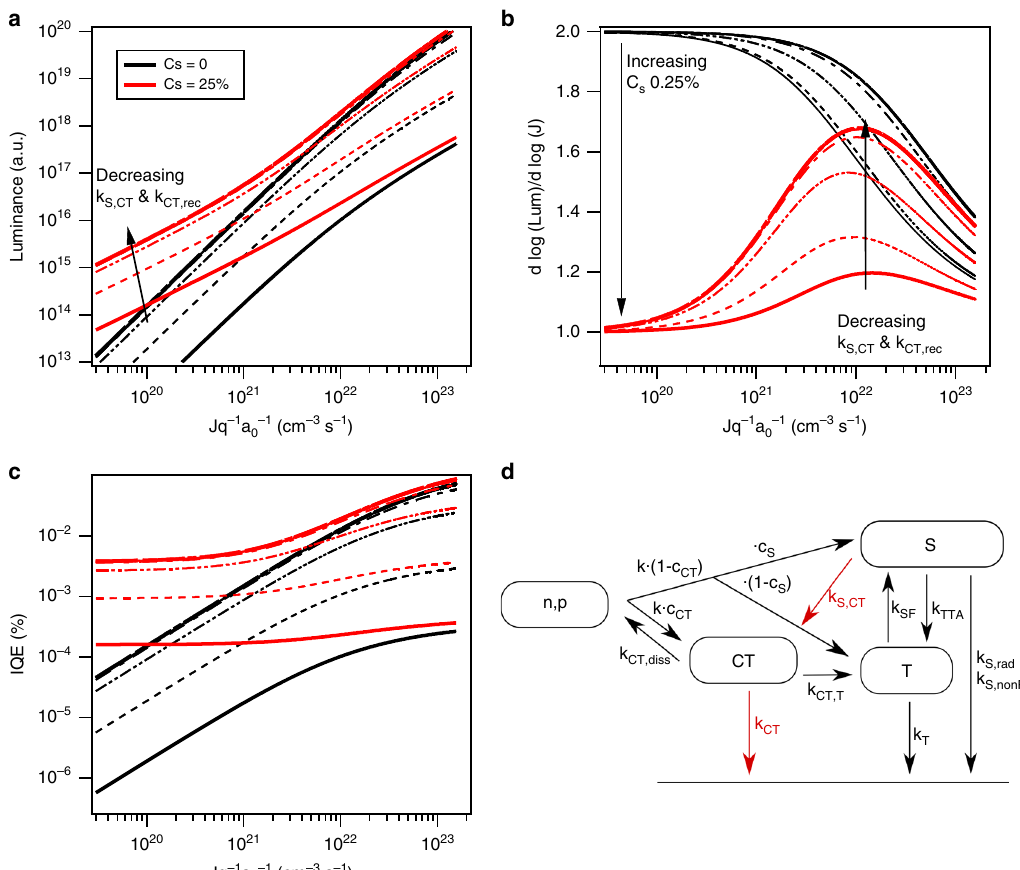
Fig. 9 Kinetic model results. a Simulated L ( J )-characteristics, ( b ) ∂ log( L )/ ∂ log( J ), and ( c ) current ef fi ciency of rubrene-based OLEDs. The data were calculated using Eq. (2) – (5) and literature values for k TTA = 10 − 14 cm 3 /s, τ T = 100 μ s, τ SF = 5 ps, τ nonRad = 50 ps, and τ rad = 15 ns, c CT = 50%, and k T ,CT = 0. Assumed values: τ CT = 50 ns; τ CT, T = 10 ps, τ S ,CT = 10 ps. The fraction of directly generated singlets, C s , has been simulated for 0 and 25%. To simulate